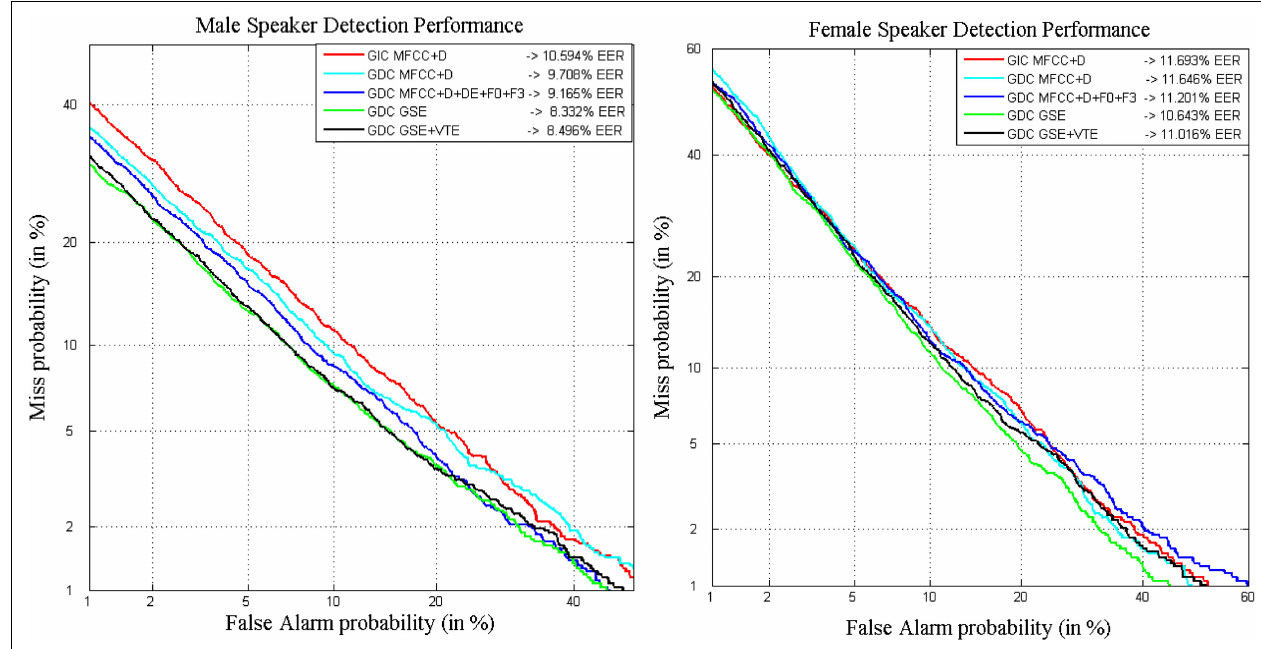
FIGURE 10 | DET curves comparing classical parameters in a gender-independent setup with the GDEB parameterization on MOBIO development set for male (left) and female (right) speakers .